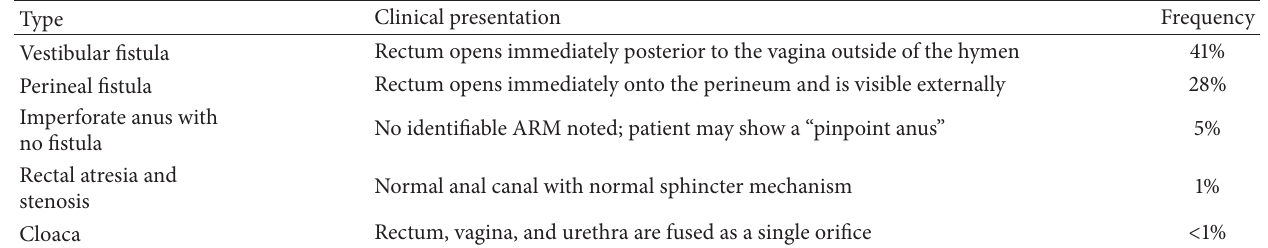
Table 1: Type, clinical presentation, and frequency of AVM diagnosed in female